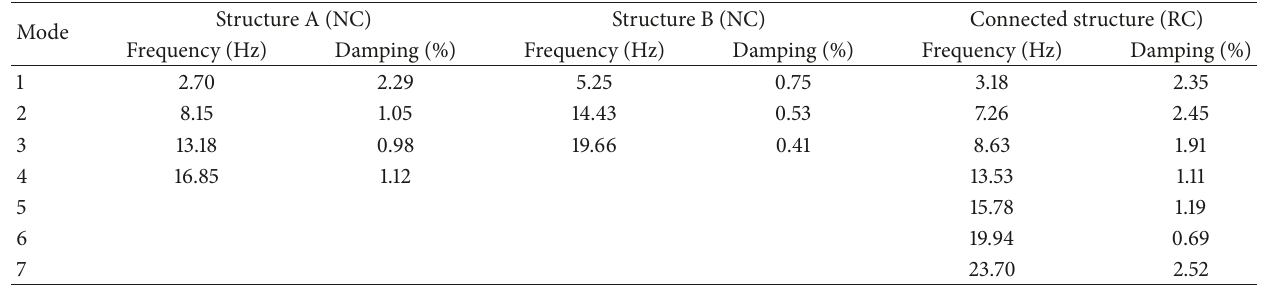
Table 11: Identified natural frequencies and damping ratios in the nonconnected (NC) and rigid connected (RC) configuration; white noise test PGA